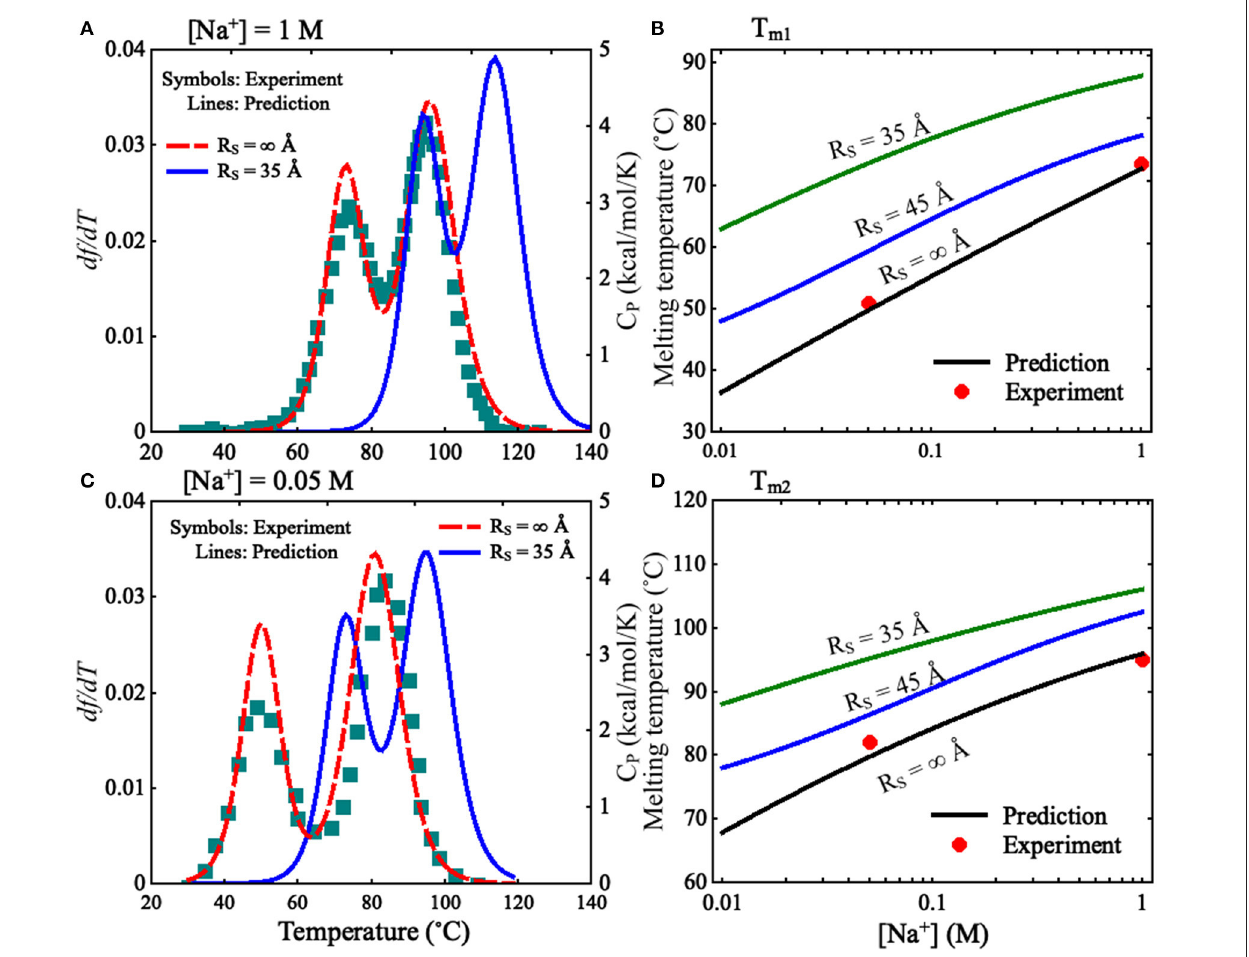
FIGURE 4 | (A,C) The predicted and experimental melting profiles for the mouse mammary tumor virus (MMTV) pseudoknot at (A) 1M [Na + ] and (C) 0.05M [Na + ]. Lines: the predicted d f /d T (the first derivative of f with respect to temperatures) for R S = ∞ Å (dashed line) and R S = 35 Å (solid line), respectively. Symbols: the experimental heat capacity C p for R S = ∞ Å. (B,D) The melting temperatures T m1 (B) and T m2 (D) as functions of [Na + ] for different R S . Symbols: the experimental data for R S = ∞ Å; lines: the predicted T m1 and T m2 for R S = ∞ , 45 Å, and 35